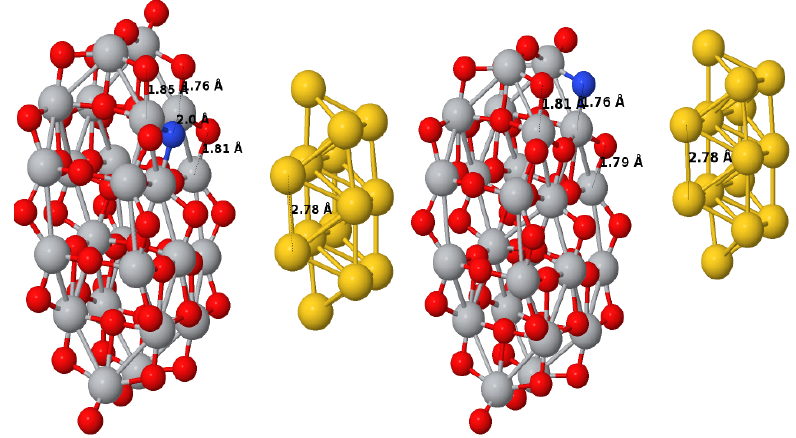
Fig. 3. Optimized geometries of two types of N-doped TiO 2 /Gold nanocomposites. The yellow, gray, red and blue balls denote gold, titanium, oxygen and nitrogen atoms, respectively.